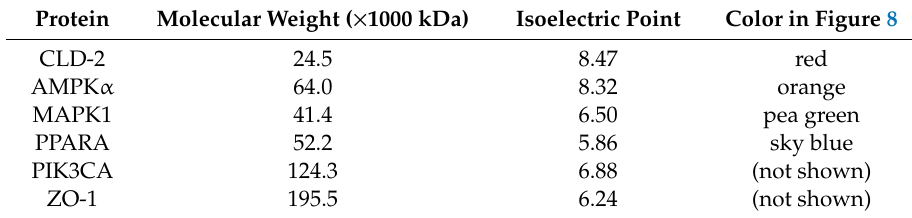
Table 1. Molecular weights, isoelectric points and colored arrows in Figure 8 of proteins that are related to TJ homeostasis. CLD: claudin; AMPK α : 5 (cid:48) adenosine monophosphate (AMP)-activated protein kinase; MAPK1: mitogen-activated protein kinase; PPARA: peroxisome proliferator-activated